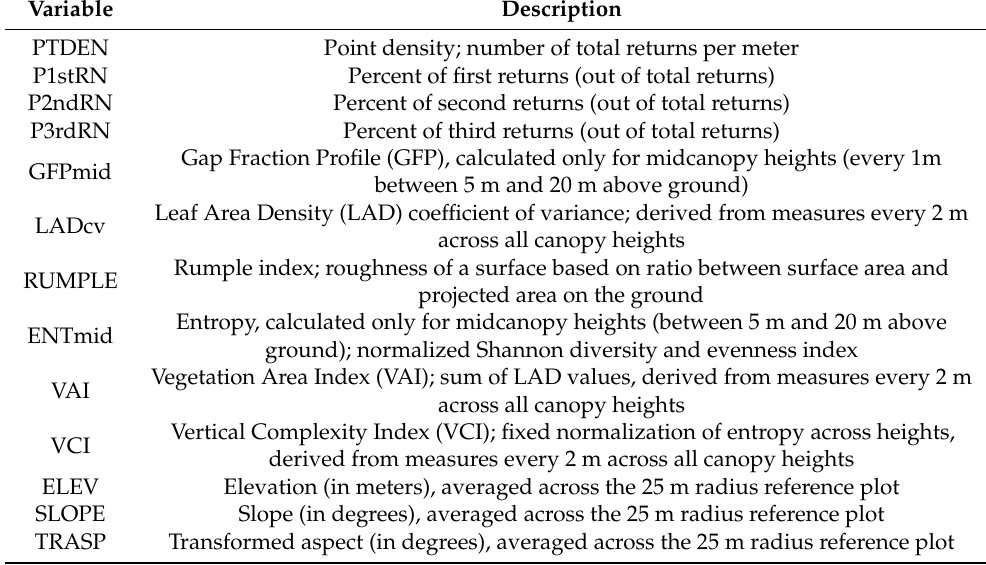
Table 2. Airborne lidar-derived metrics used as predictor variables in RF models to classify snag characteristics of snags measured in Idaho coniferous forests. For additional information on equations and ecological significance of each predictor variable, please see Appendix A Table